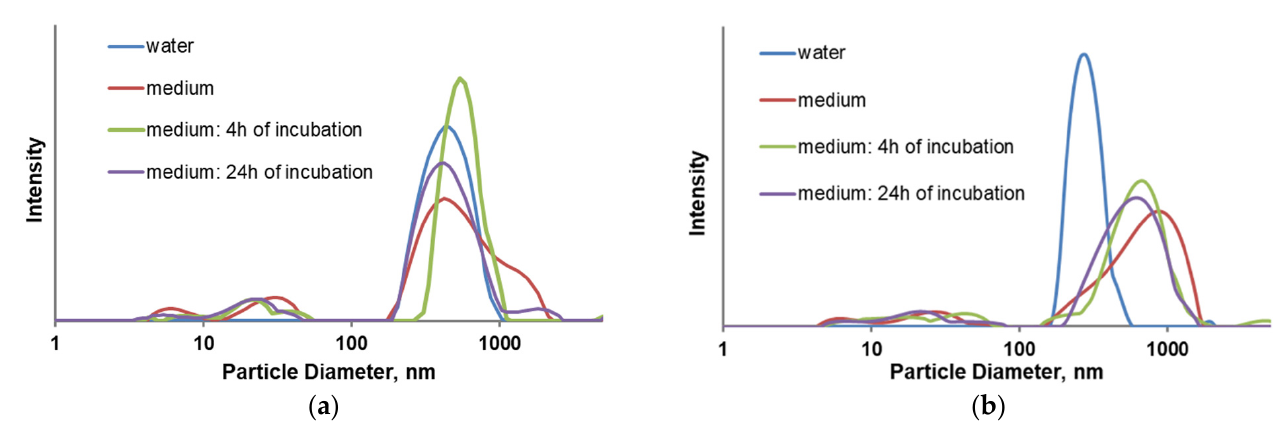
Figure 4. Particle size distribution of ( a ) MSN-H1[Ir] and ( b ) MSN-H2[Ir] in water and culture medium. Figure 4.